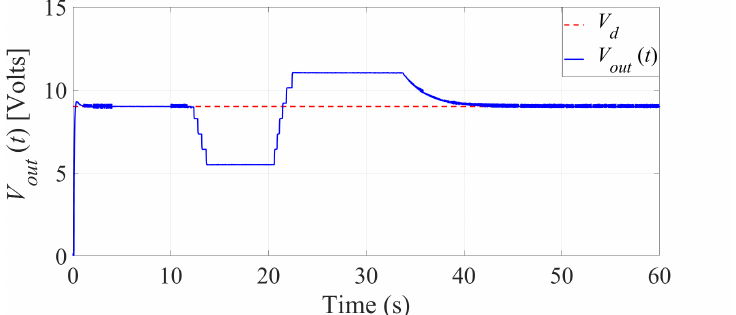
Figure 20. Desired voltage value ( V d ) and performance of the output voltage ( V out ( t ) ) implementing a classical PID controller.